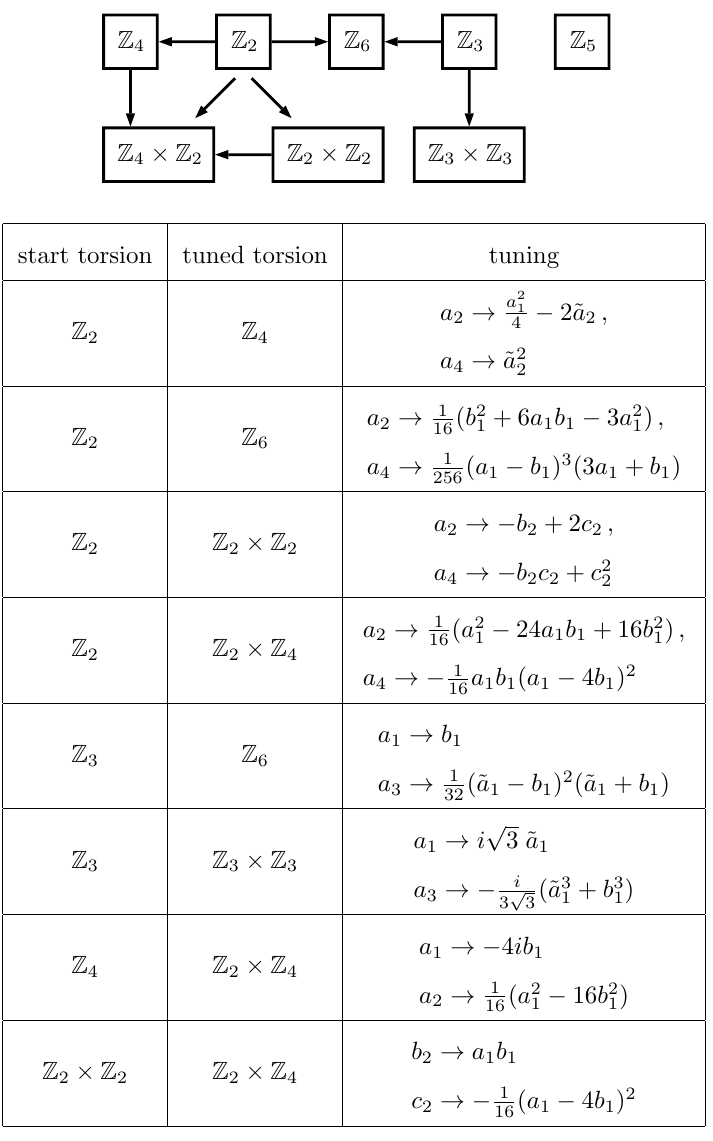
Table 5 . Chain of torsion enhancements and their explicit globally de(cid:12)ned Weierstrass